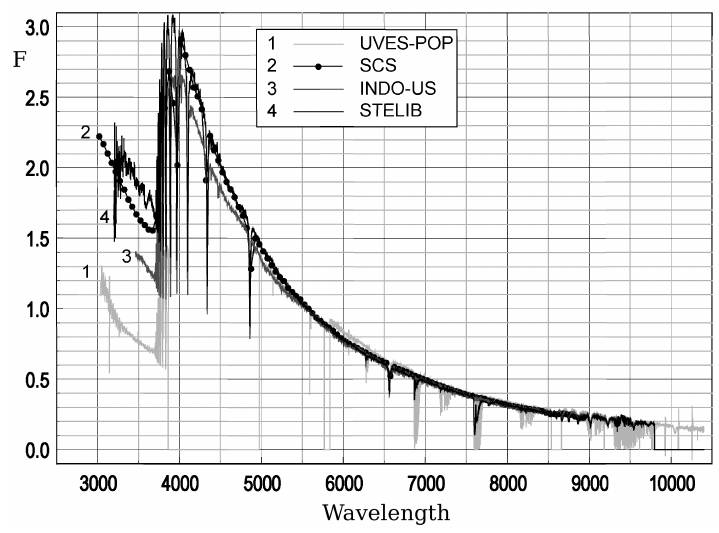
Fig. 8. The spectral energy distribution of (cid:11) Leo, as presented in different atlases. The curves are normalized at 5500 ˚A. Note a significant disagreement in the UV